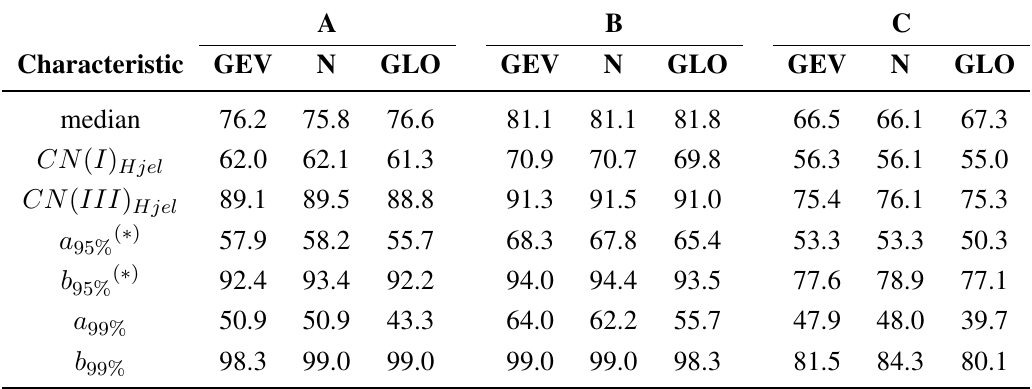
Table 3. Characteristics of the distribution of CN obtained from the distribution fitting of 100- CN .